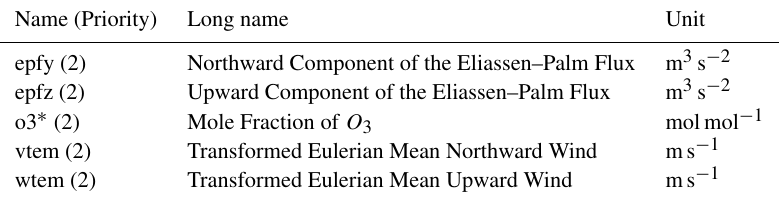
Table 5. Variables in the 6hrPtZ data table. Zonal mean, instantaneous atmospheric (YPT) output at 6h intervals. See Sect. 5 for meaning of priority levels.